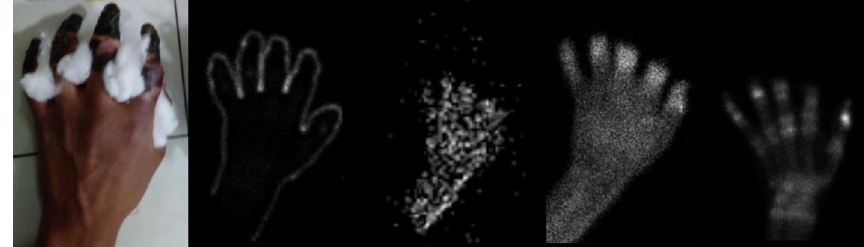
Fig. 4 High clinical-imaging correlation showed for the right hand. Clinical appearance of a fourth-grade frostbite injury. Peripheral marking of the hand with 99mTc-MDP to delimit the contour.